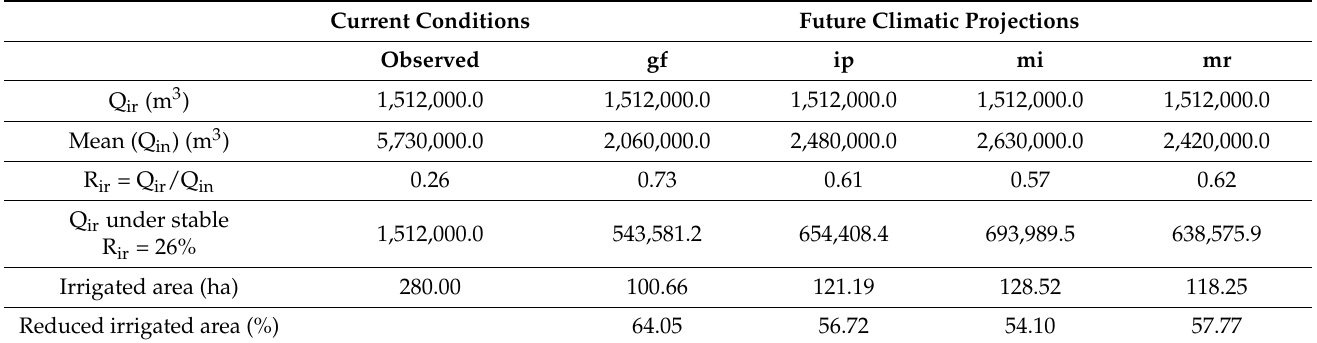
Table 7. Pressure analysis of irrigation under current climatic conditions and future climate